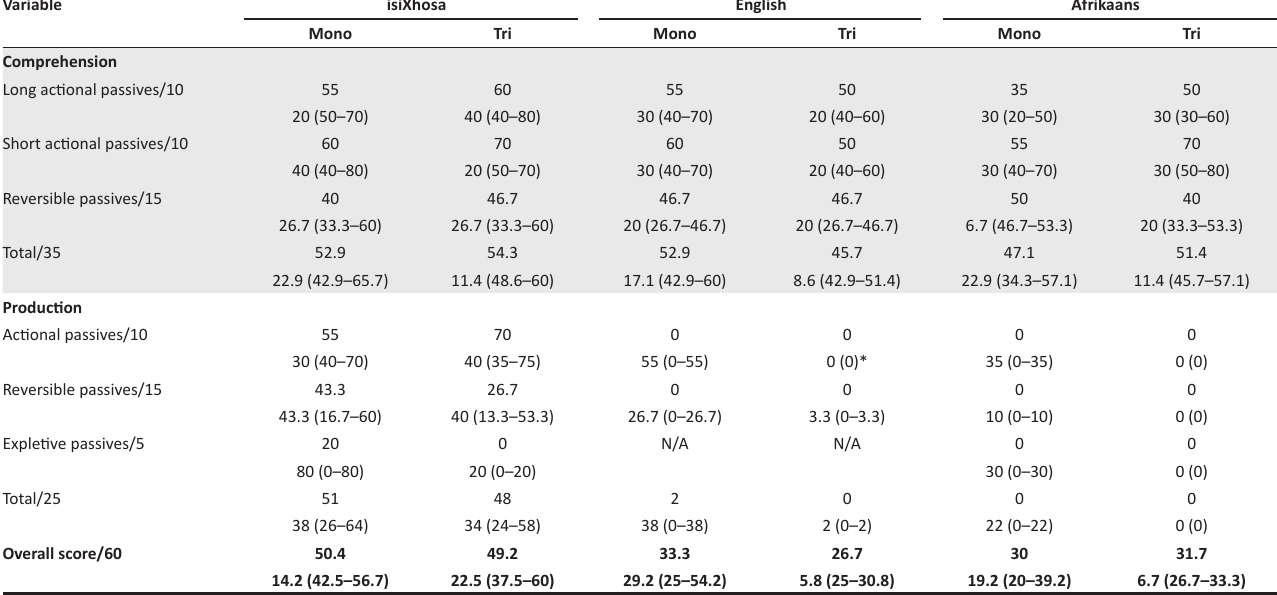
TABLE 3: Monolinguals’ ( n = 10 per language group) versus trilinguals’ ( n = 11) median scores on the REALt, as percentages with IQR below it. Variable isiXhosa English Afrikaans Mono Tri